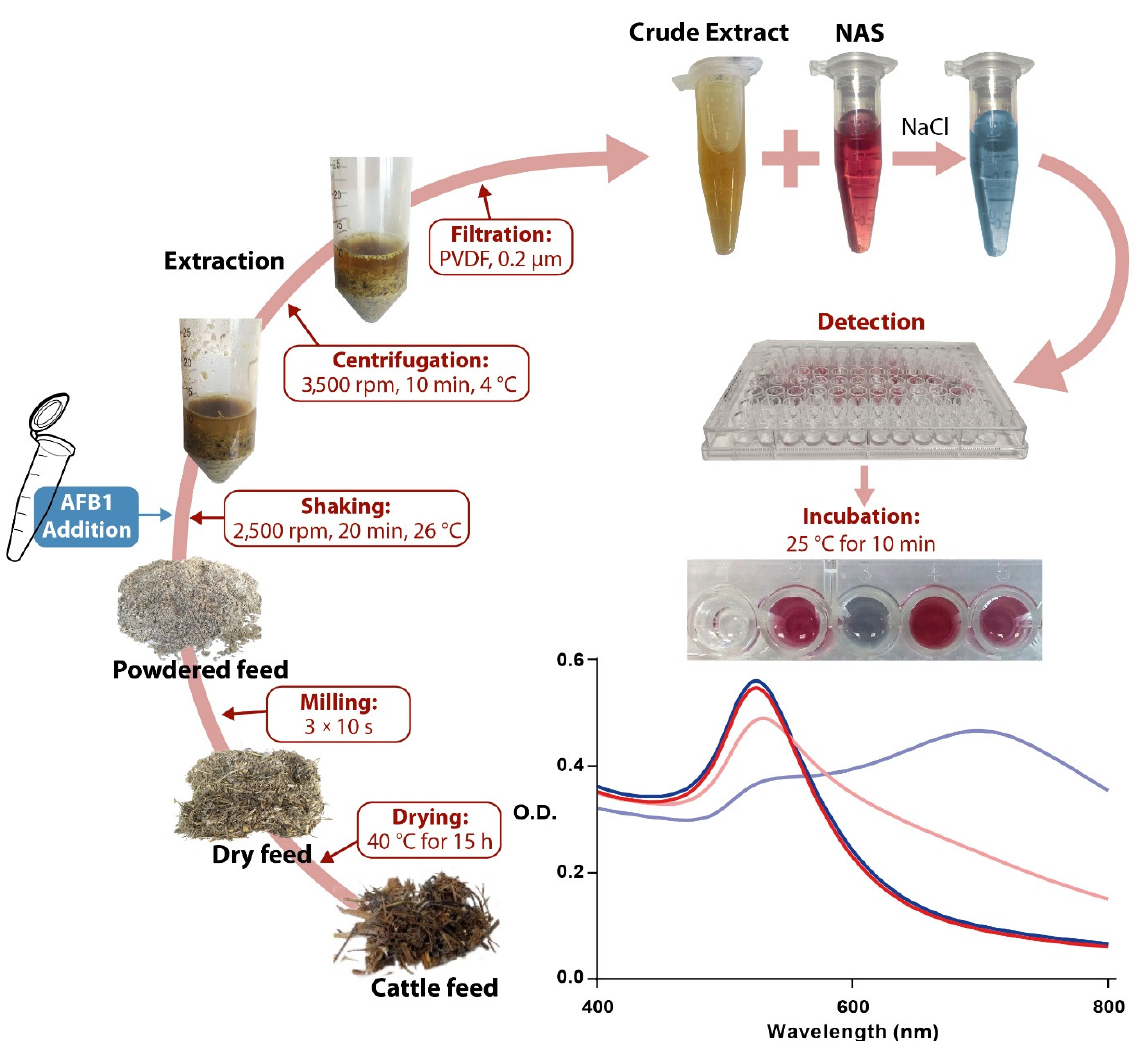
Figure 6. Schematic illustration of preanalytical and analytical phases of the NAS assay to detect AFB1 in cattle feed samples.